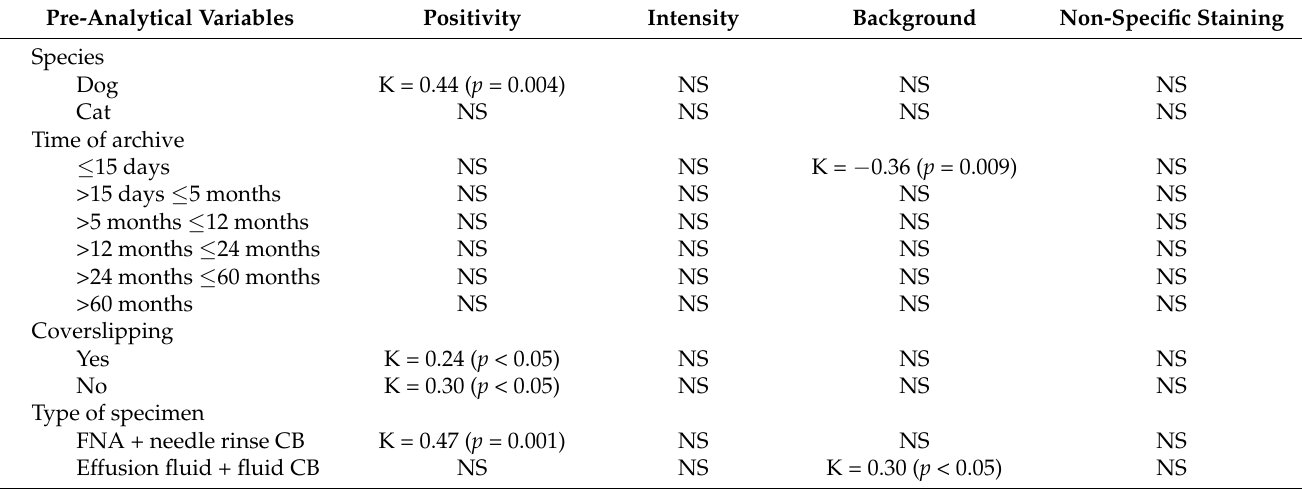
Table 3. Variation of the agreement (kappa values) of the parameters of the CD3 immunolabeling applied to previous Romanowsky-stained cytology slides and of the CD3 immunolabeling of CB on cell blocks (as evaluated by a board-certified pathologist) according to the pre-analytical variables: species, time of archive, coverslipping, and type of specimen (NS